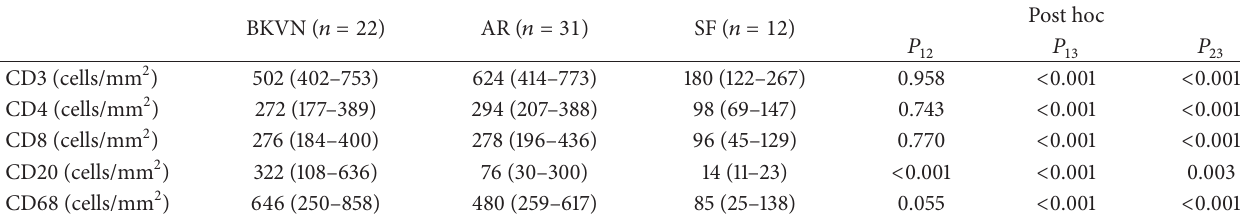
Table 2: Inflammatory cellular constituents in different groups.